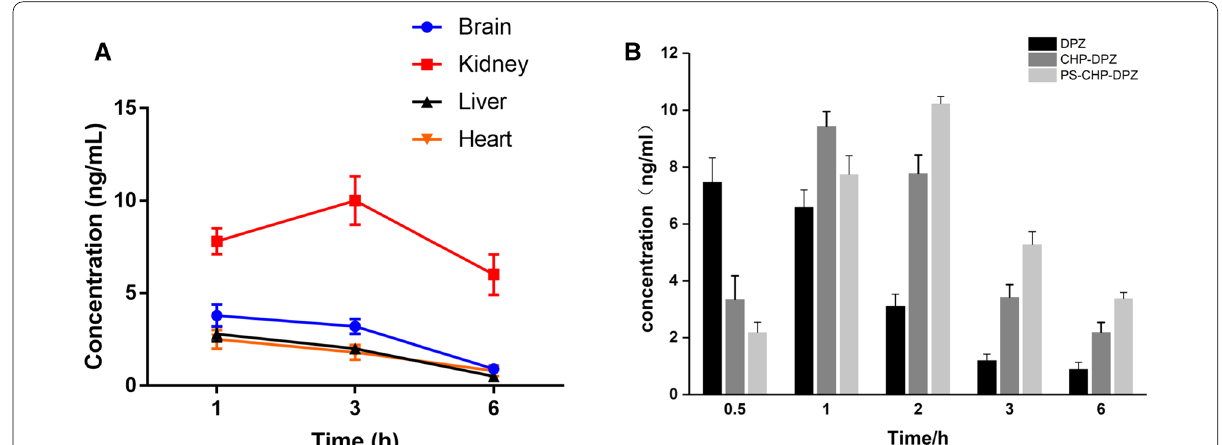
Fig. 6 a The concentration of donepezil in the brain, heart, liver and kidney at different times. b The concentrations of free DZP, DZP-CHP nanosolution and DZP-CHP nanosolution modified with PS in brain tissue at different times